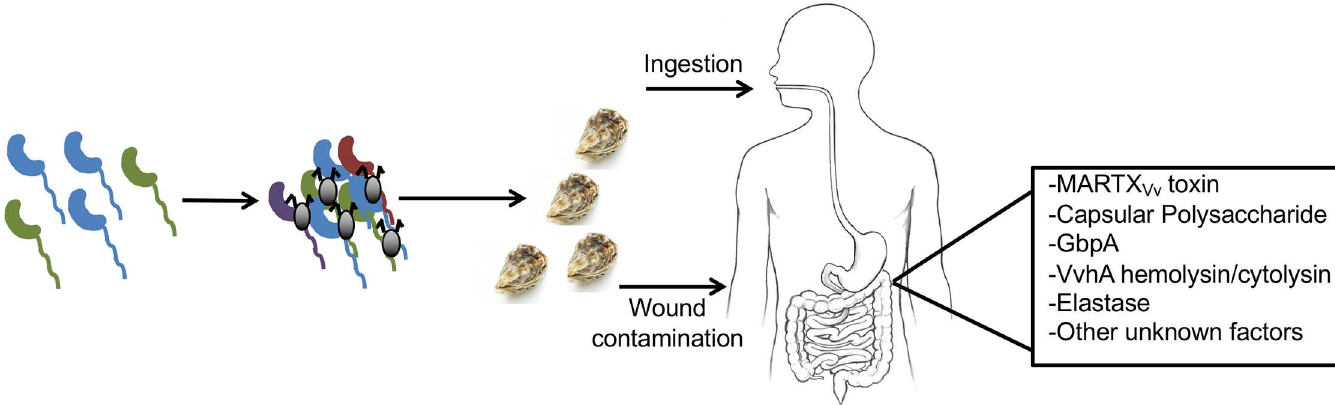
Fig 1. A comprehensive model for V . vulnificus environmental and pathogenic life cycles. V . vulnificus exists in coastal waters, where it exchanges geneticmaterial via HGT, continuously forming new strains. Via GbpA, V . vulnificus binds to chitin in the ocean, which is consumedby filter-feeders such as oysters, which are in turn consumed by humans. Depending on the strain, V . vulnificus may go on to become pathogenicto humans via severalknown virulencefactors and likely other unidentified